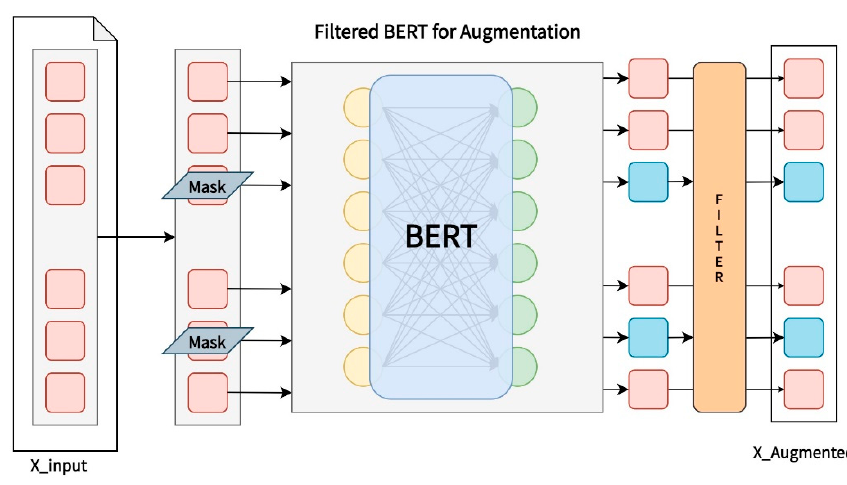
Figure 2. Detailed structure of filtered BERT augmentation algorithm.